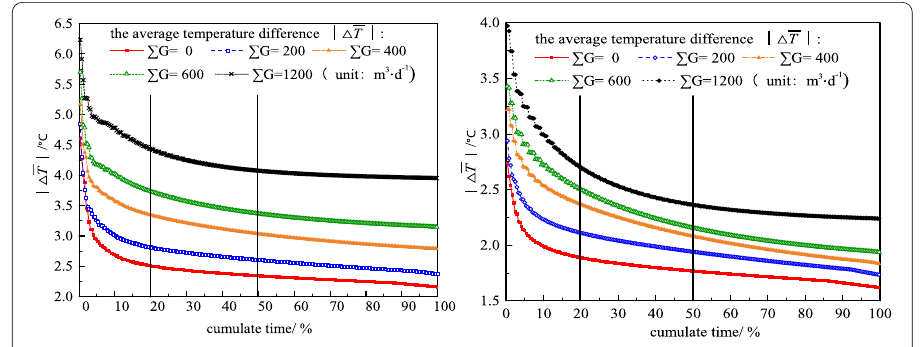
Fig. 13 Cumulative distributions of the temperature difference of the inlet and outlet water of the BHEs: a the cooling stage; b the heating